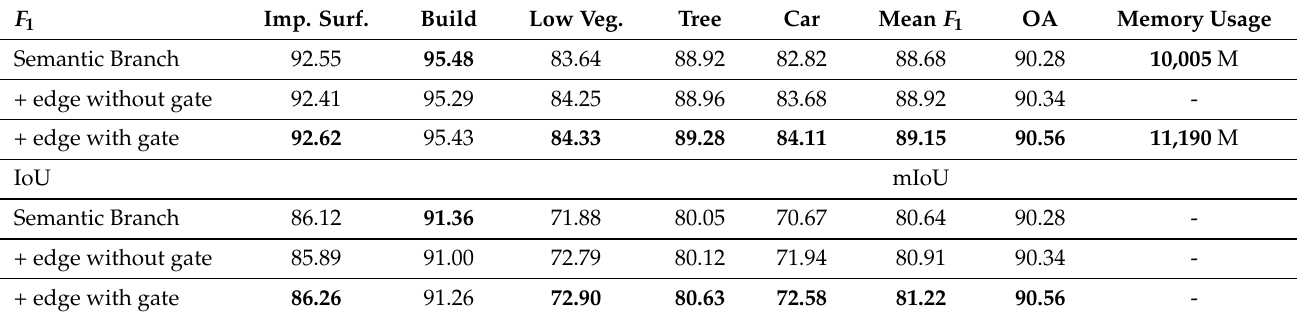
Table 6. Ablation study for the edge